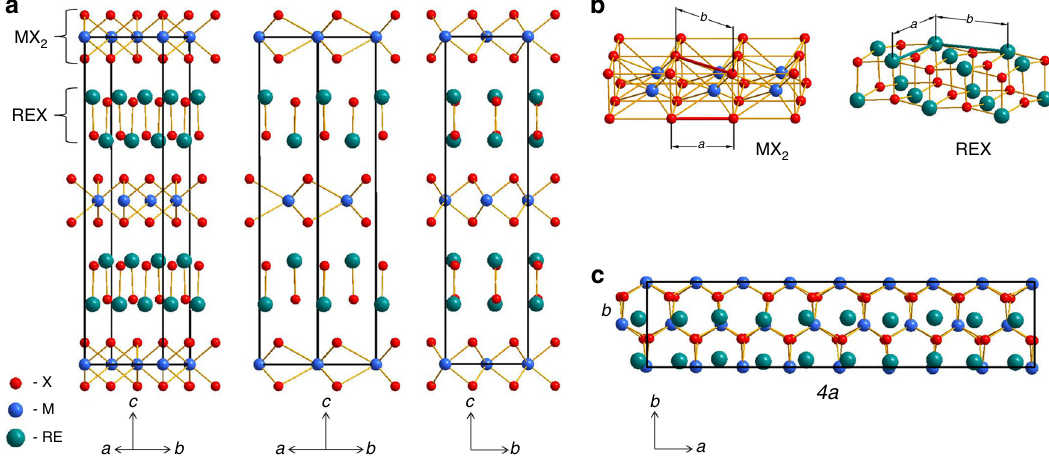
Fig. 1 Schematic illustration of 3D heterostructures. Schematic of (REX) 1 + x (MX 2 ), where M = transition metal, for example, Nb or Ta, RE = rare-earth metal, for example, La or Sm, and X = S or Se. a The three different projections shown can be observed by STEM imaging. b Perspective views of MX 2 and REX building blocks. c Projection of the heterostructure shown in a along [0 0 1] direction highlighting incommensurability along the a -axis with chalcogen atoms in the REX fragments omitted for